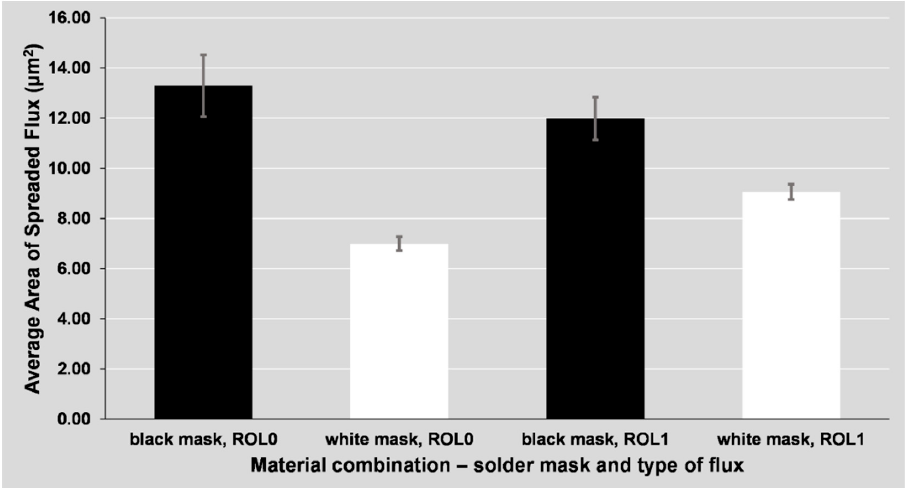
Figure 7. Average area of spread flux around the soldering pad depending on the solder mask and flux type.